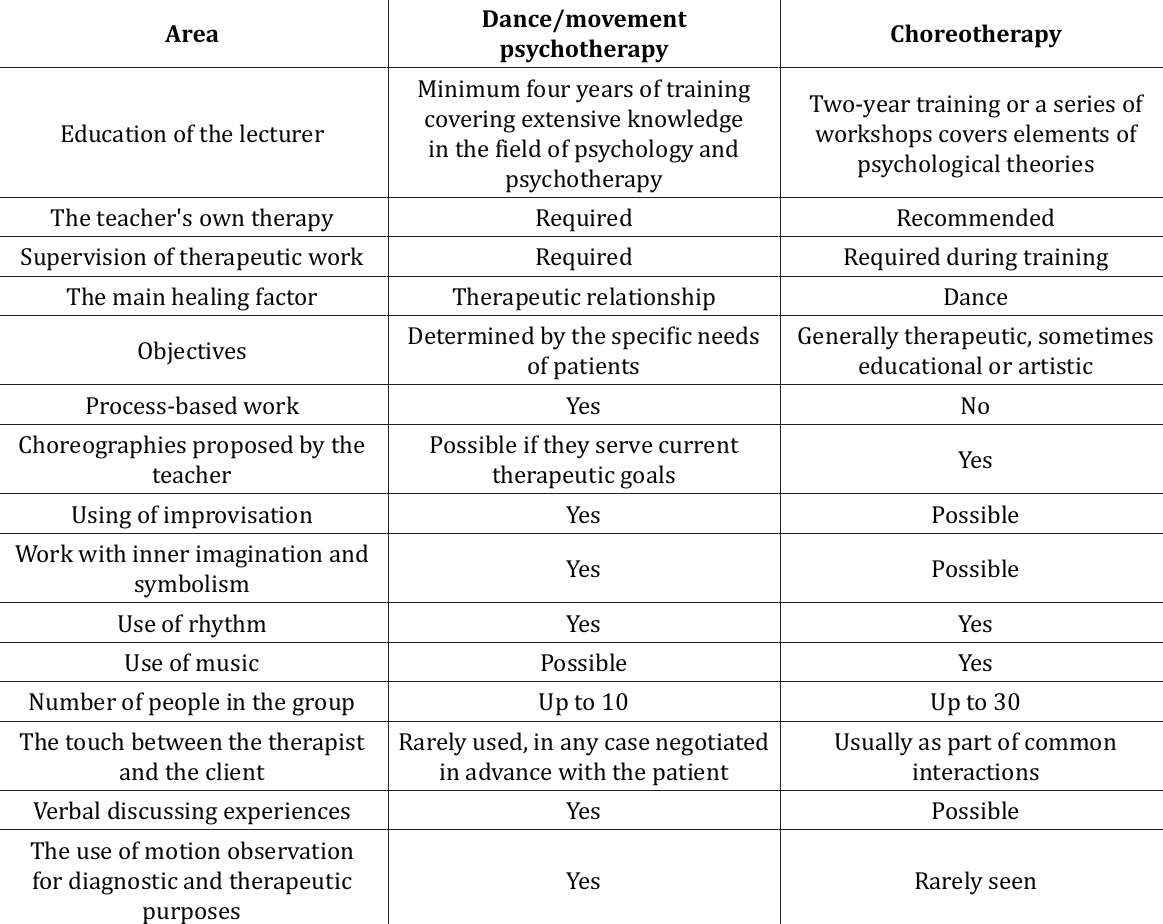
Table 1. Comparison of dance and movement psychotherapy with choreotherapy (source: